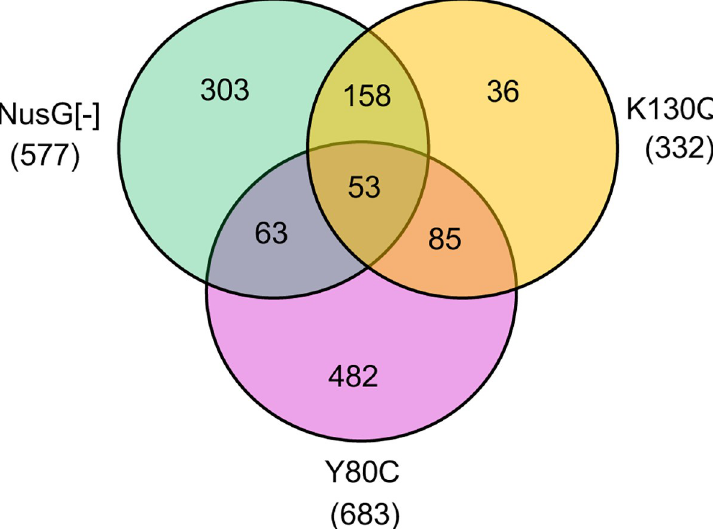
Fig 7. Venn diagram showing the distribution of genes affected by NusG depletion and/or Rho mutations. Only genes whose transcript levels increase 2-fold or more (log2FoldChange versus wt � 1; padJ � 0.05) under at least one of three conditions applied in this study (ARA treatment; Rho mutants Y80C and K130Q) were considered. Circle overlap areas denote genes responding to more than one condition. The gene names are listed in S2 Table. Note that for some genes, group assignment is critically dependent on the log2FoldChange and padJ cutoff values. For example, by setting log2FoldChange to � 0.8 and padJ to � 0.01, the number of genes responding to K130Q and not to the other conditions drops to